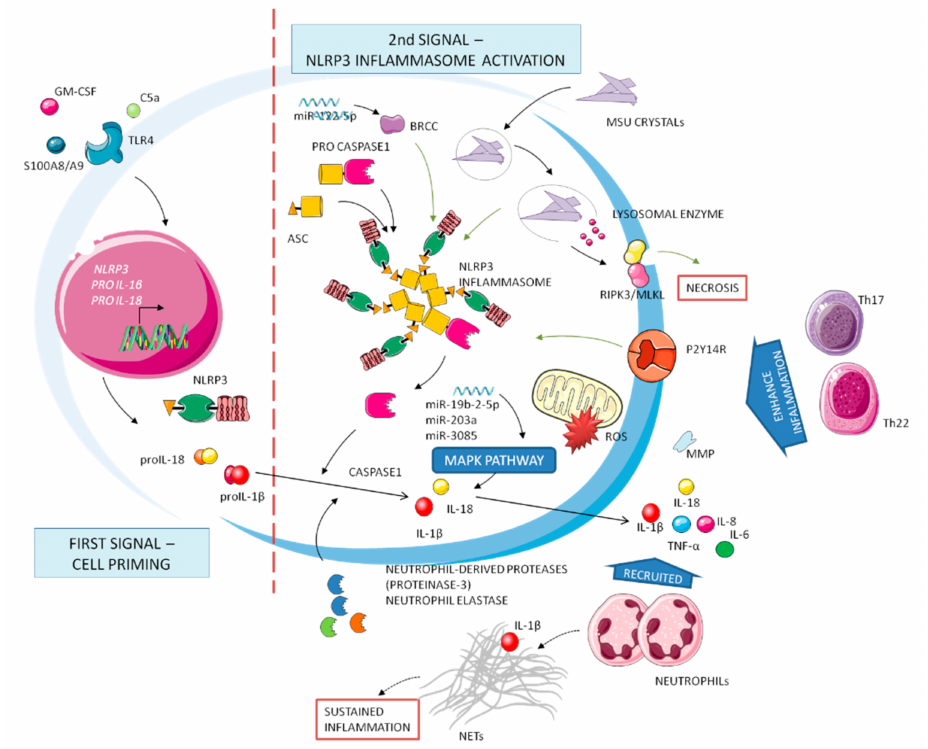
Figure 1. Complex network of molecular mechanisms implicated in gout. Inflammation has been defined by two stages: first signal ( left ) and second signal ( right ). Cell priming production of precursors of cytokines and inactive inflammasome molecules needs the subsequent activation step after Signal 2. IL-1 β is critical to the upregulation of inflammatory